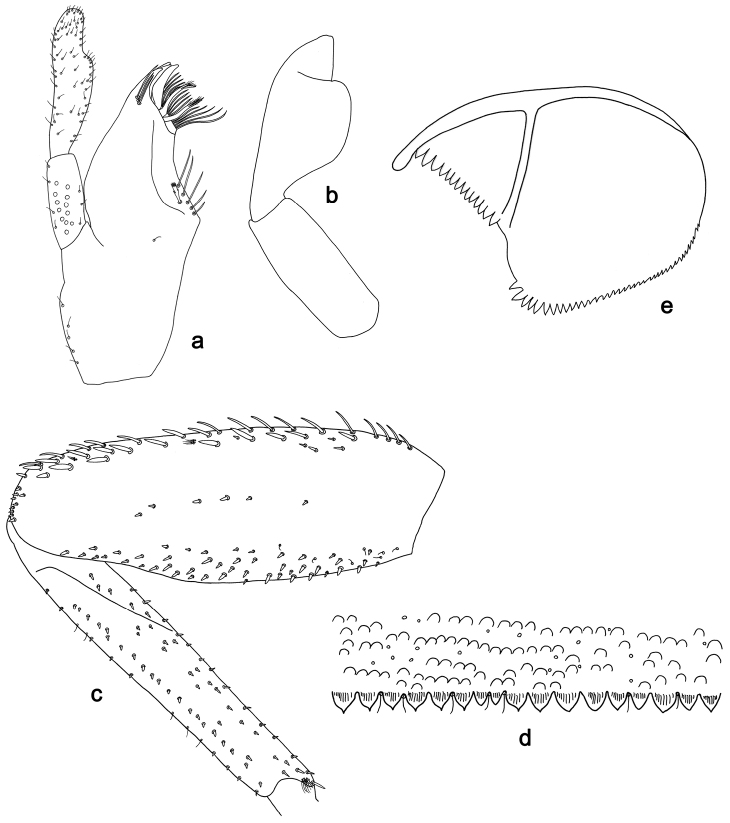
Labiobaetistuberpalpus, larva morphology: a Maxilla b Labial palp cForeleg (femur, tibia) dTergum IV.